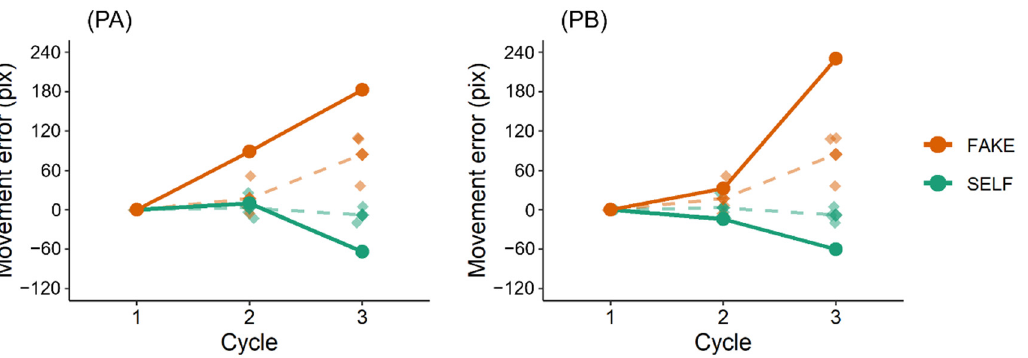
Figure 3. Movement errors. Rhombus plots and dashed lines show movement errors of healthy participants (mean and individual values). Movement errors in all participants were smaller in the SELF condition ( − 63.31–4.91 pix) than in the FAKE condition (36.76–230.19 pix).